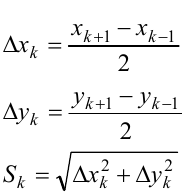
Figure 5. Errors of image pattern tracking for synthetic image pattern of d